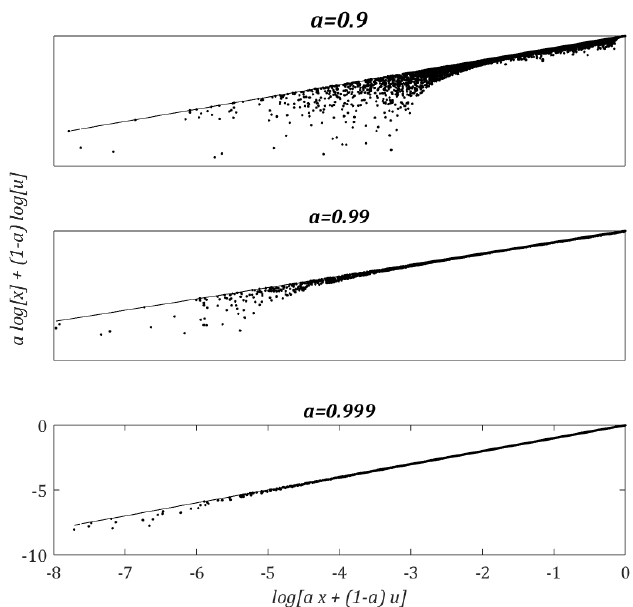
Figure 4. Numerical evaluation of the lower bound (Equation (5)) for di ff erent values of a . The line in the graphs corresponds to equality (Equation (6)). For a given value of a , the variables x and u are sampled randomly in the unit interval, each point corresponding to a particular realization.